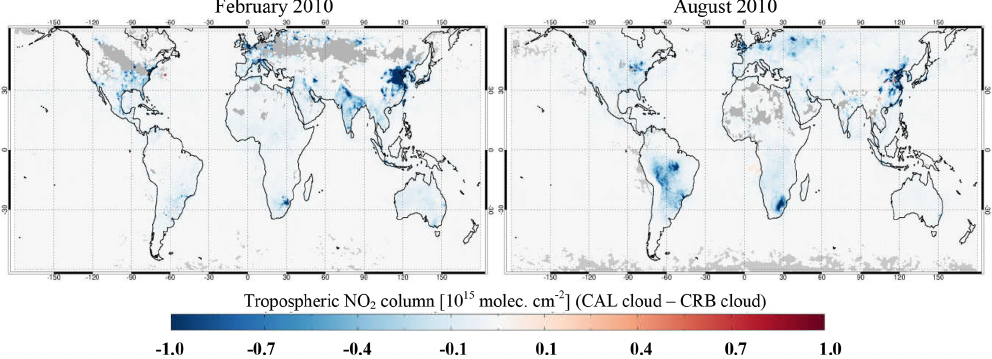
Figure 12. Differences in the GOME-2 tropospheric NO 2 columns retrieved using the ROCINN_CRB and ROCINN_CAL cloud models in February and August 2010. Only measurements with a cloud radiance fraction less than 0.5 are included. Cloud observations with a fitting rms greater than 1 × 10 − 4 or a number of iterations greater than 20 are filtered out.